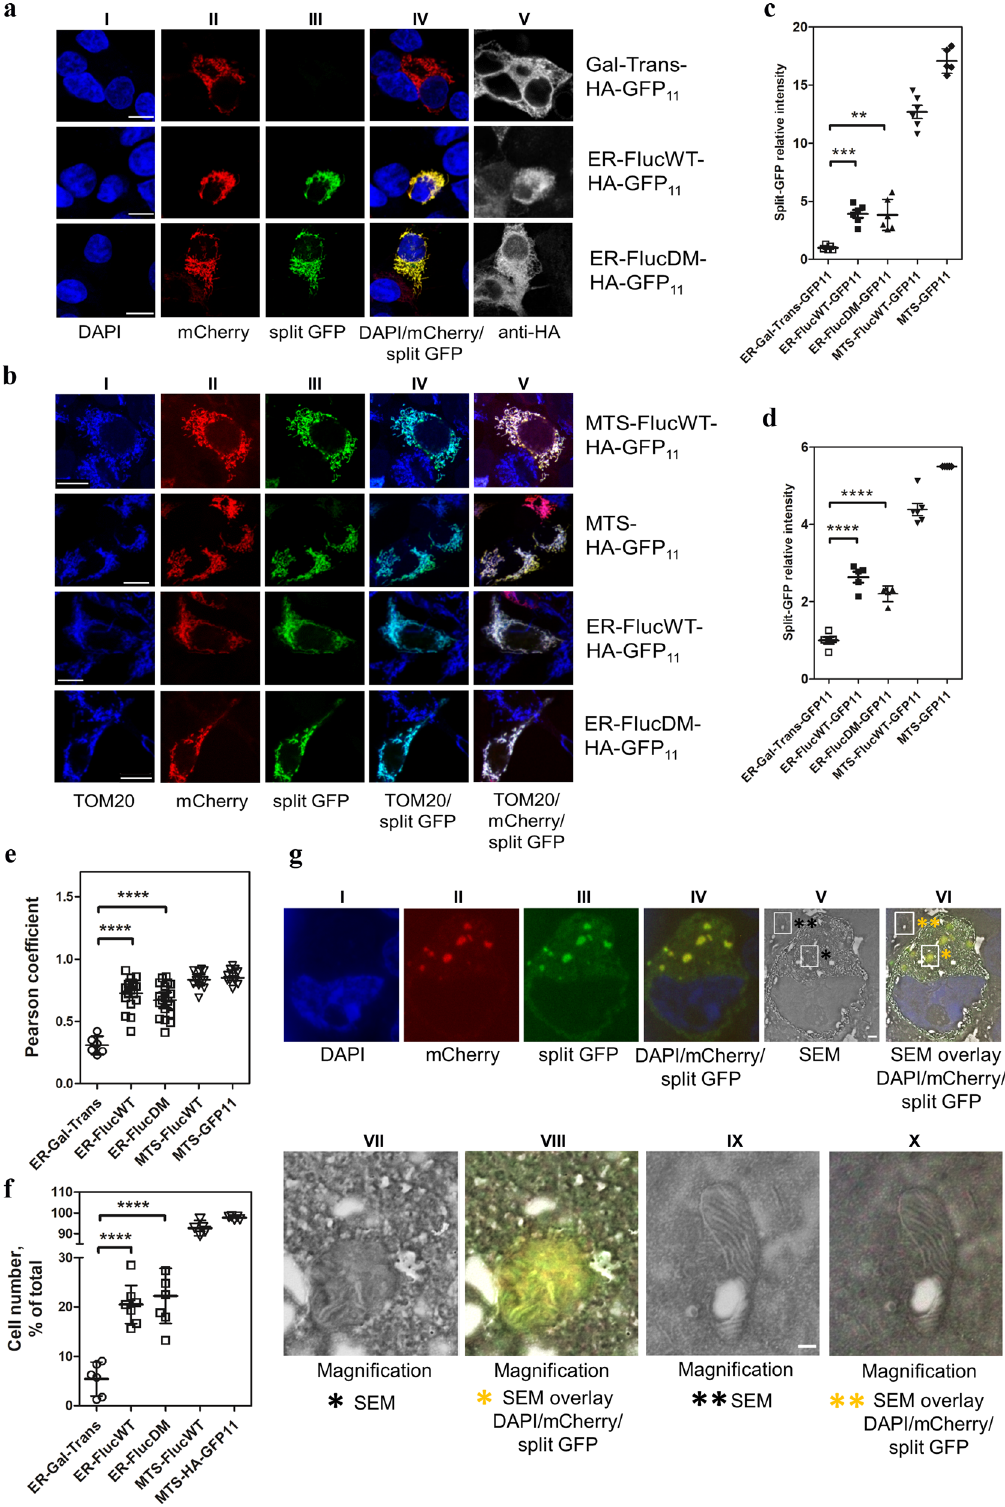
for quanti fi cation Fig. 2c, d). These data were further corroborated using Pearson ’ s correlation coef fi cient for co-localization analysis of split-GFP and MTS-mCherry fl uorescent signals (Fig. 2e). To control for the transfection and expression ef fi ciency of the reporters, we used antibodies speci fi c to the HA-tag, and quanti fi ed the percentage of cells showing co-localization of split-GFP with MTS-mCherry signals relative to the total number of cells expressing both HA-tag